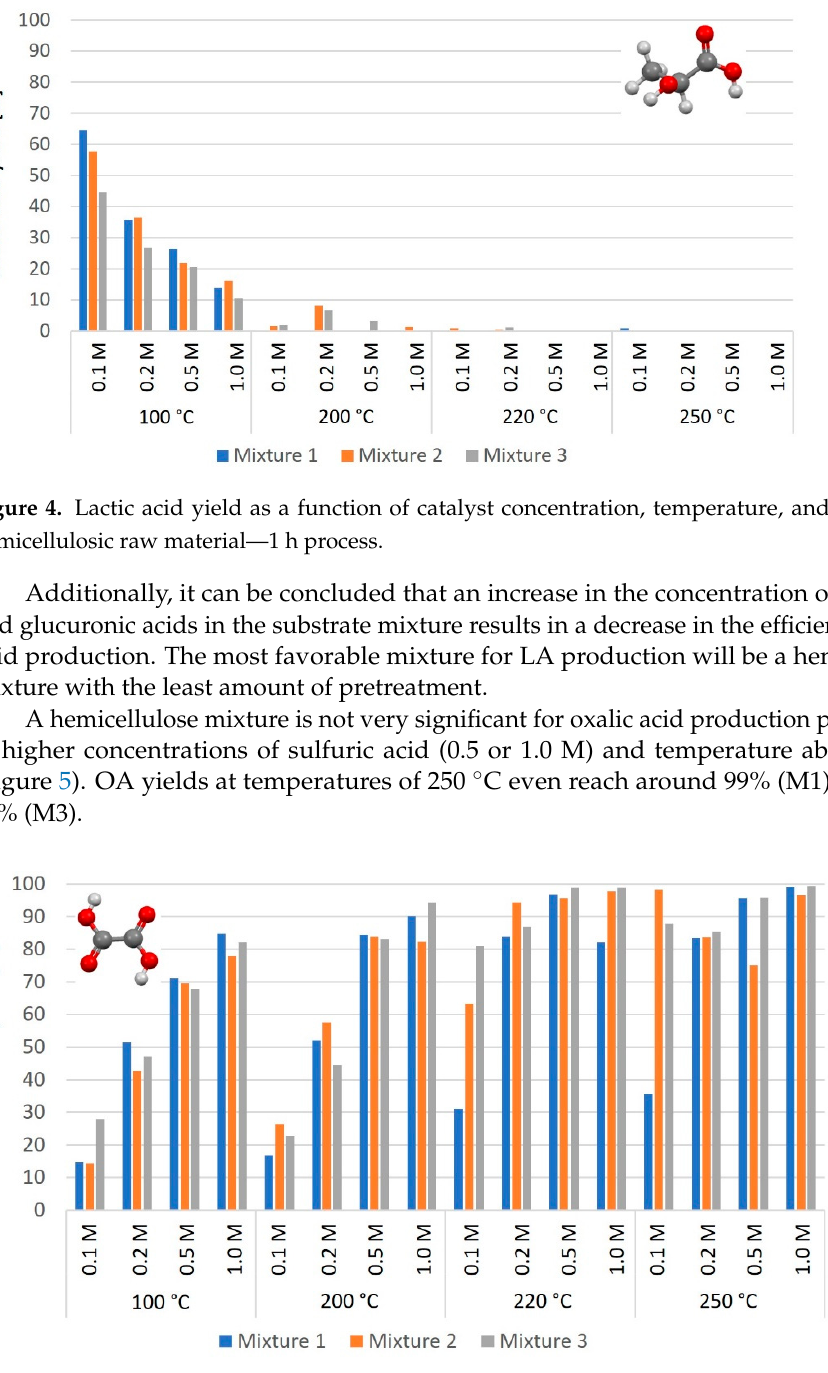
Figure 5. Oxalic acid yield as a function of catalyst concentration, temperature, and mixtures of hemicellulosic raw material—1 h process.